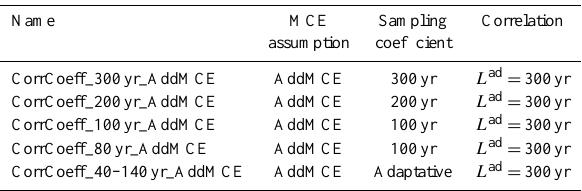
Figure 6. Sensitivity of the solution to correlation coefficient val- ues applied between duration constraints (infinite depth range case). Top panel: GICC05 minus background chronology (black dashed line), Difference between analysed and background chronologies (blue to pink lines). Bottom panel: MCE (black dashed line) and analysed errors (blue to pink lines) The duration constraints are sampled every 100 years on GICC05, and correlation coefficients range from 0.8 to 0.2. The MCE assumption is AddMCE (full error correlation between cycles). Table 2. Summary of the simulation configurations for the experi- ments of Sect. 2.4.2. Finite range versus infinite range error corre- lation influence.